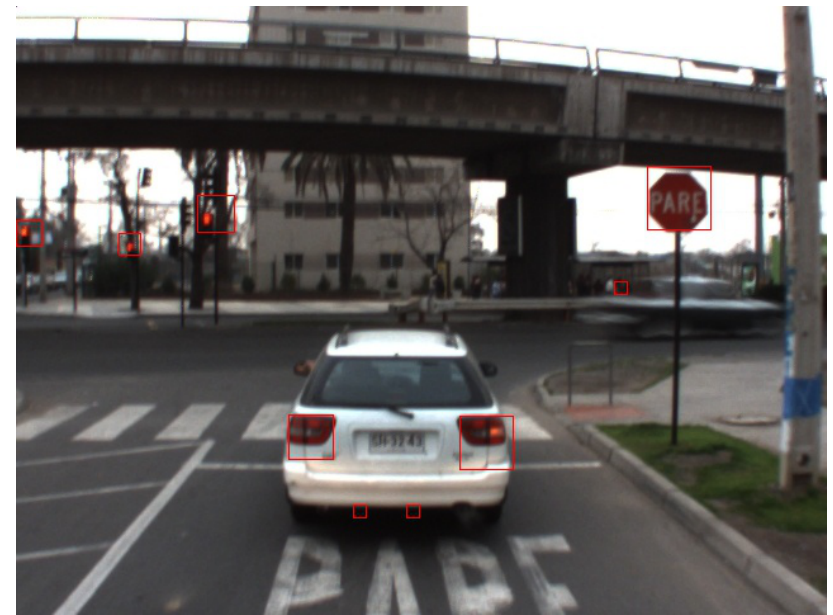
Figure 4. Example of ROIs obtained after removal/merging of overlapping pre-candidates selected with the chromaticity